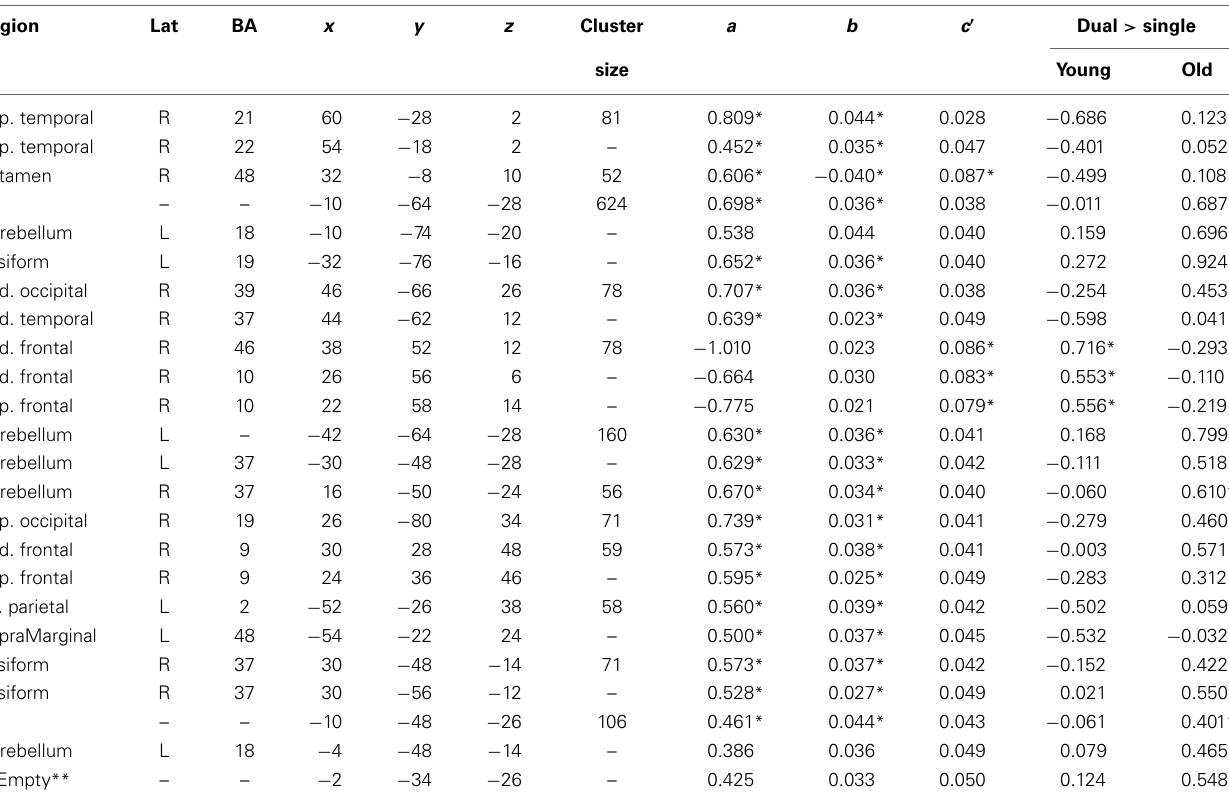
Table 3 | Mediation analysis